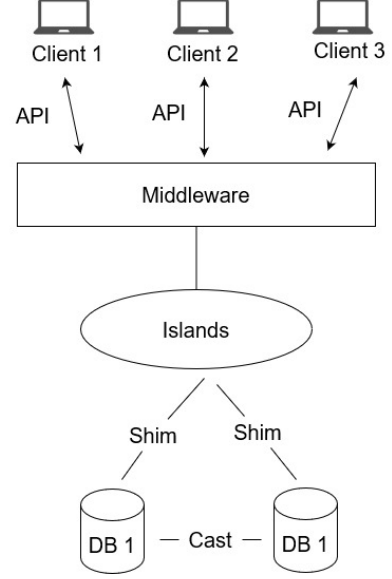
Figure 2. BigDAWG Architecture [63].